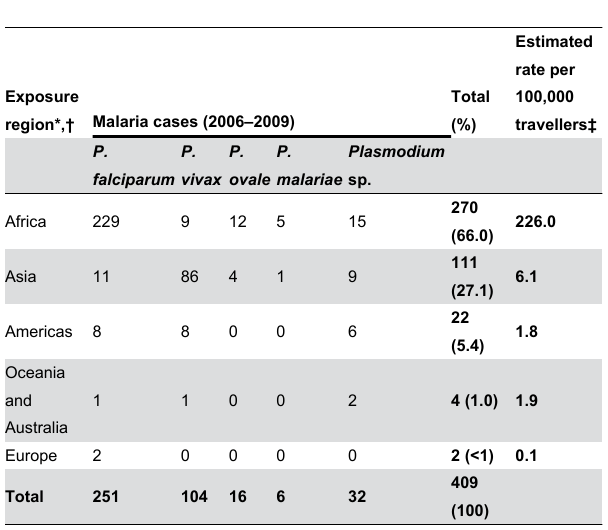
Table 3. Exposure regions for imported malaria cases in Ontario, Canada